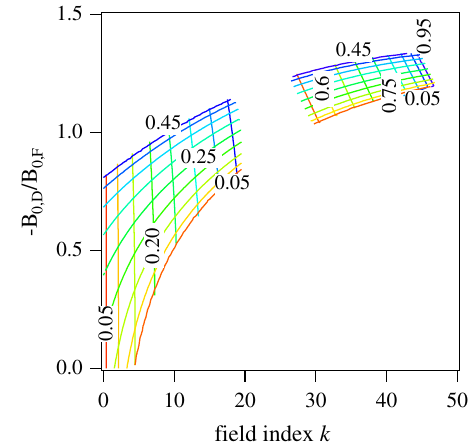
FIG. 1. (Color) From Ref. [13]. Stability diagram shows two stability regions. Upright numbers indicate vertical cell tune and vertically aligned numbers indicate horizontal cell tune. Lines are drawn with 0.05